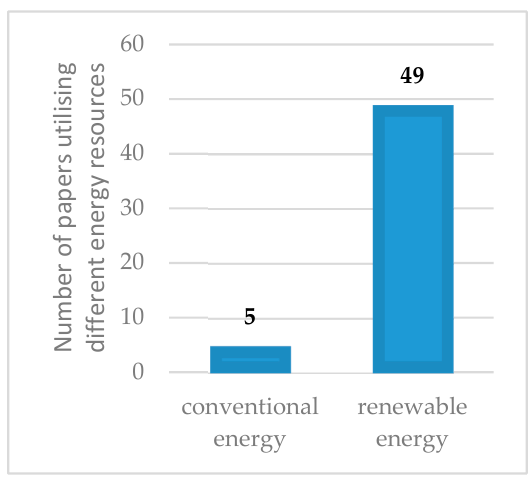
Figure 8. Distribution of empirical data by energy resource.